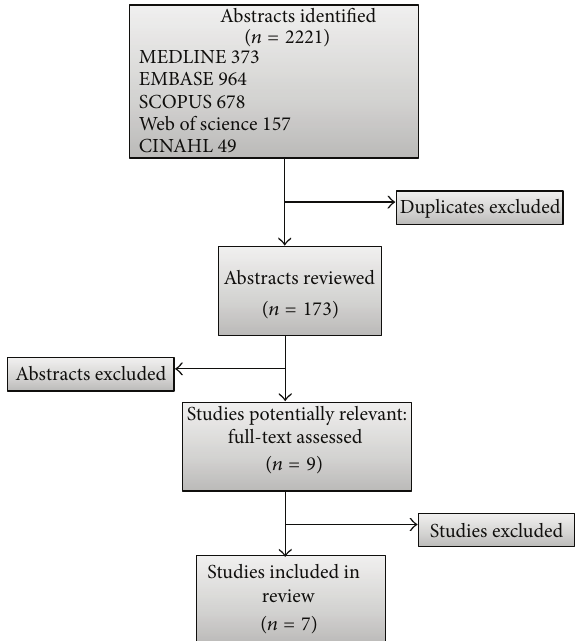
Figure 1: Flow chart describing study selection